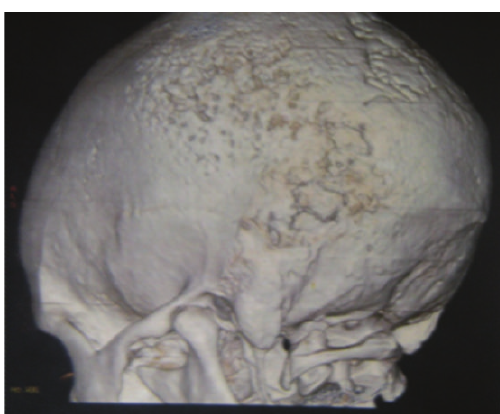
Figure 4: 3D reconstructed images of the